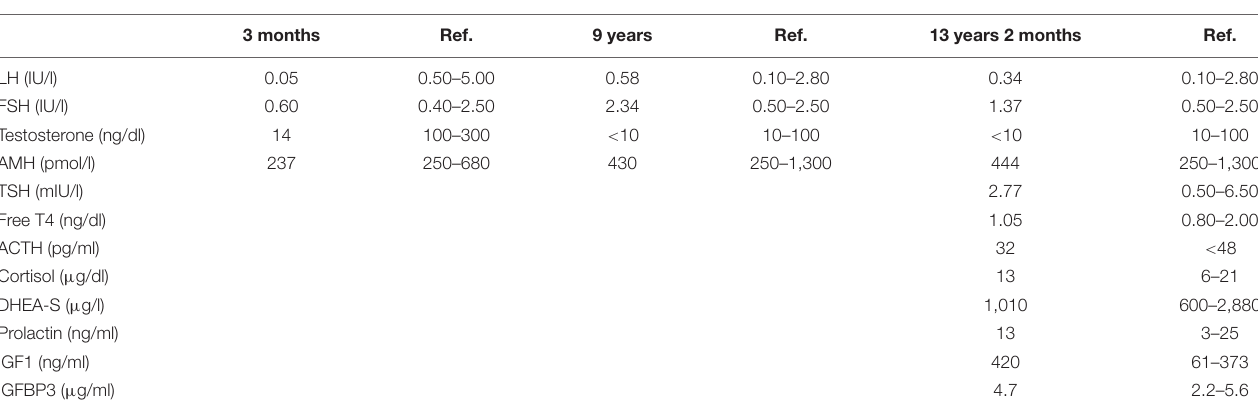
FIGURE 1 | Case pedigree and growth chart. (A) Pedigree: the arrow indicates index case; circle, females; square, males; full black square, complete phenotype (small genitalia and hyposmia); half black square, incomplete phenotype (normal genitalia development and olfactory dysfunction). (B) Growth chart of index case, using Argentine standards for males. MPH: adjusted mid-parental height. The blue bars indicate periods of testosterone enanthate treatment. TABLE 1 | Laboratory findings in the index case at different